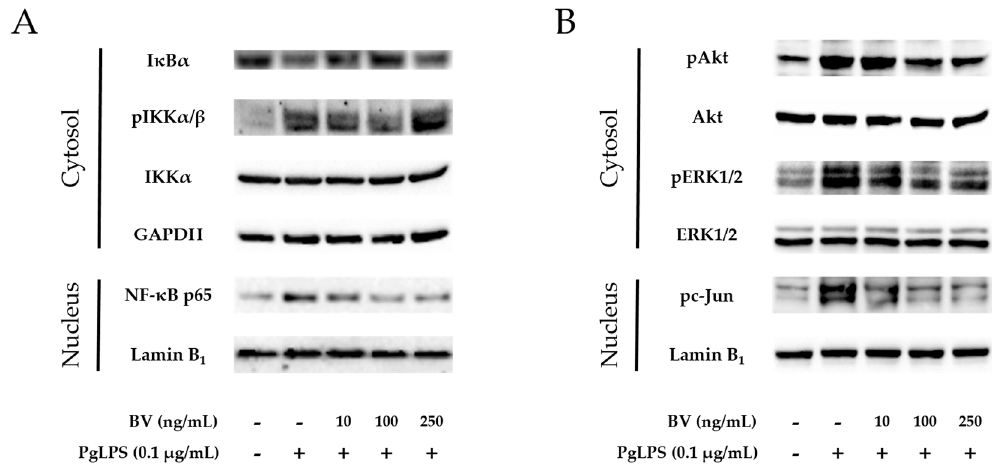
Figure 3. BV inhibits the NF- κ B signaling pathway and activation of Akt, ERK1/2 and c-Jun in